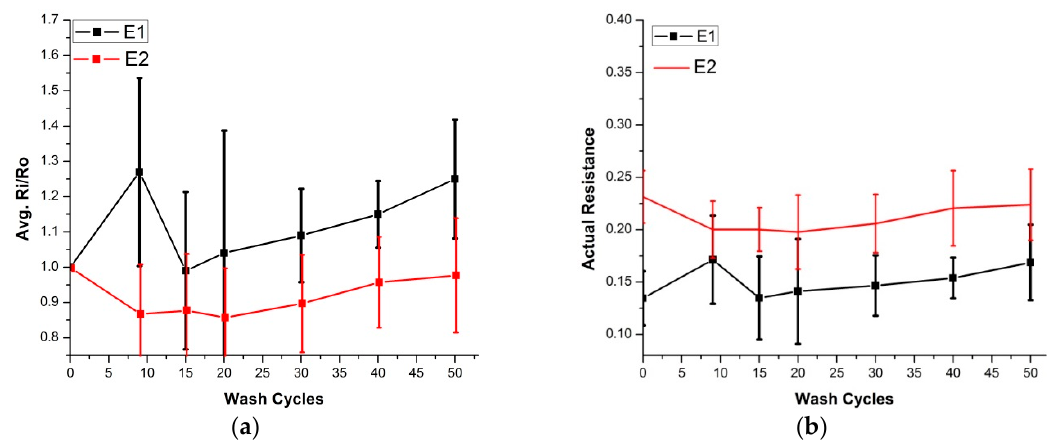
Figure 10. Surface resistance analysis (silk wash), four samples of each electrode were tested, ( a ) Comparison of Ri/Ro ( b ) Comparison of actual resistance.